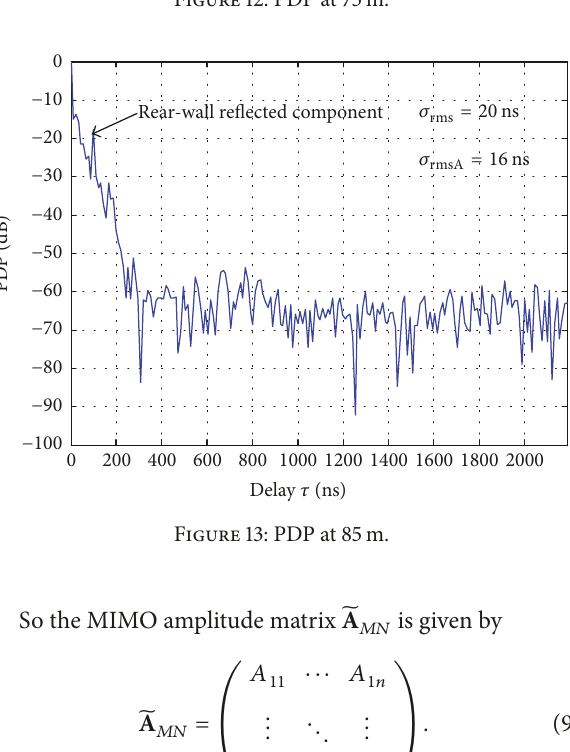
Figure 9: PDP at 25m.